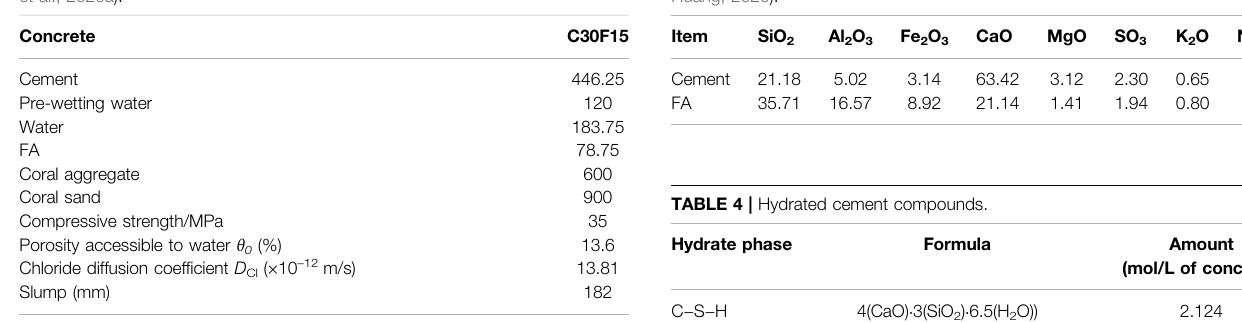
TABLE 2 | Mix proportion of CAC in kg/m 3 , and primary characteristics (Huang et al., 2020a).